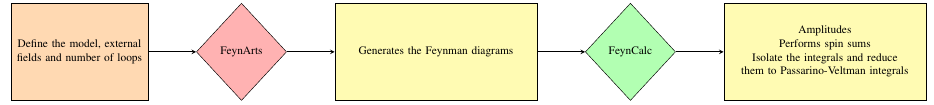
Figure 1: Semi-automated approach for computing scattering matrix amplitudes employing the Mathematica packages FeynArts [2] and FeynCalc [3]